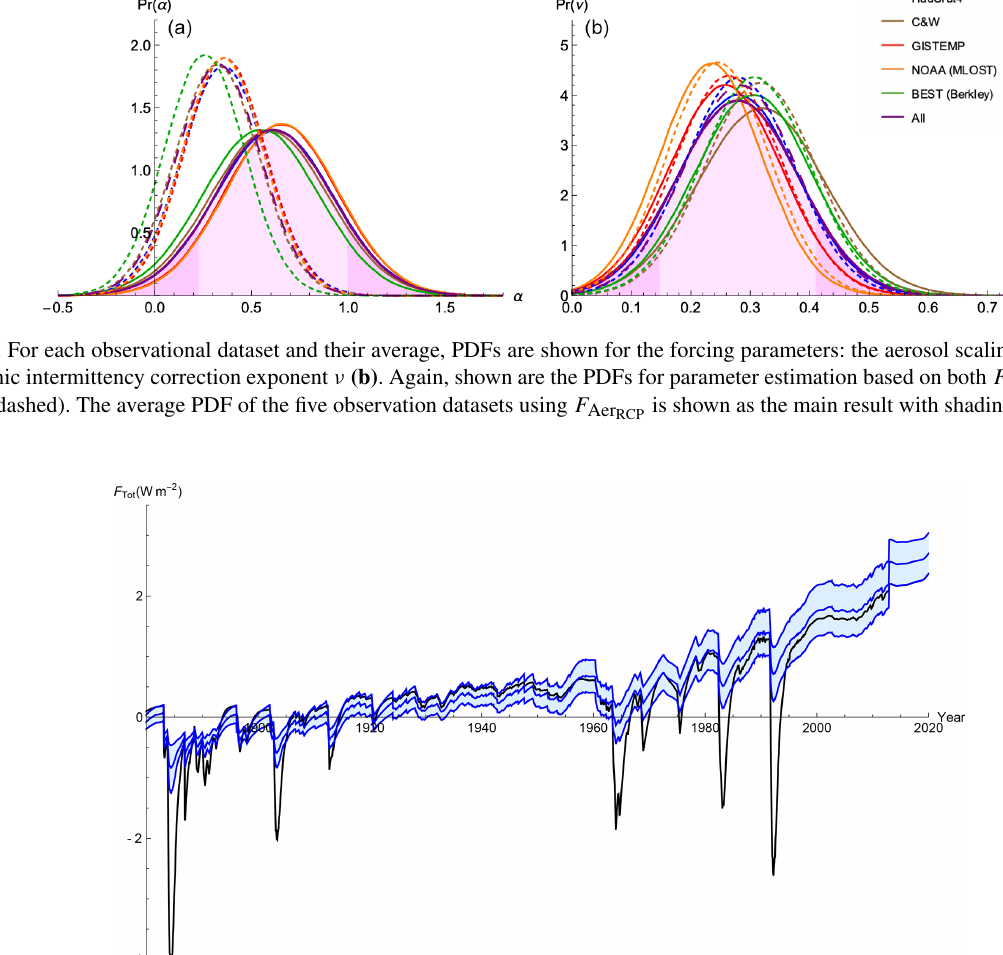
Figure 6. The total historical (1880–2020) forcing series prescribed by the IPCC using, F Aer F Tot ( α,ν ; t ) (blue), which takes into account aerosol and volcanic corrections, shown with 90%CI.